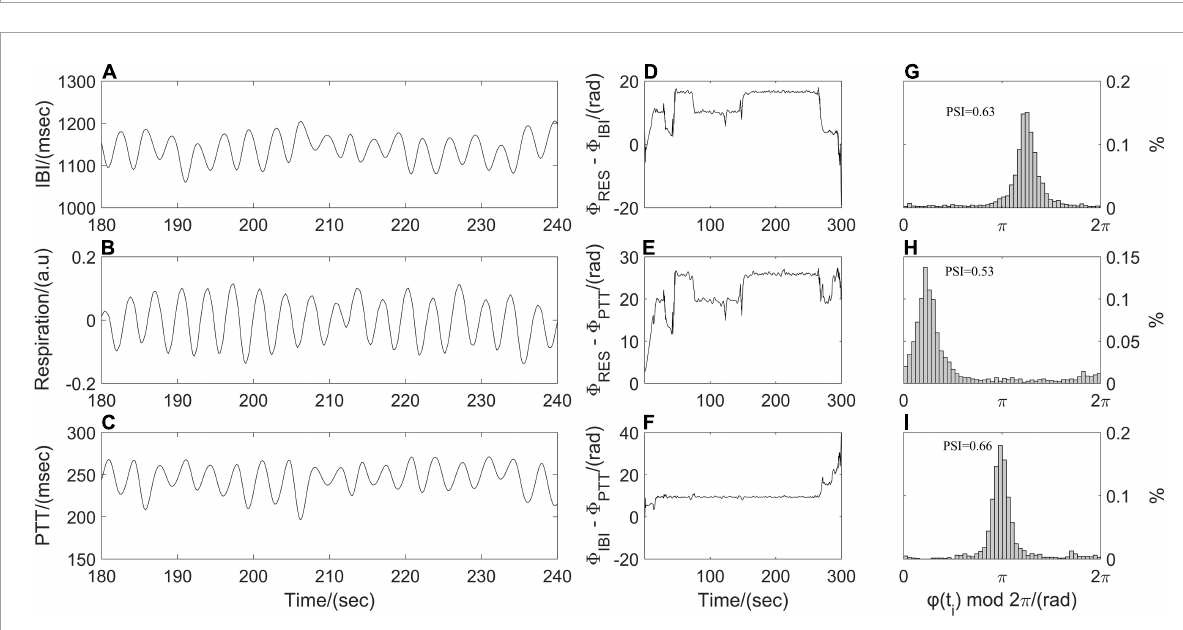
FIGURE3 Illustration of phase synchronization analysis. (A) Interbeat interval (IBI) time series, (B) respiratory signal, (C) pulse transit time (PTT) time series; instantaneous phase differences (D) between respiratory signal and IBI time series, (E) between respiratory signal and PTT time series, (F) between IBI and PTT time series; and the distribution of ϕ (t i ) mod 2 π (G) between respiration and IBI, (H) between respiration and PTT, (I) between IBI and PTT.